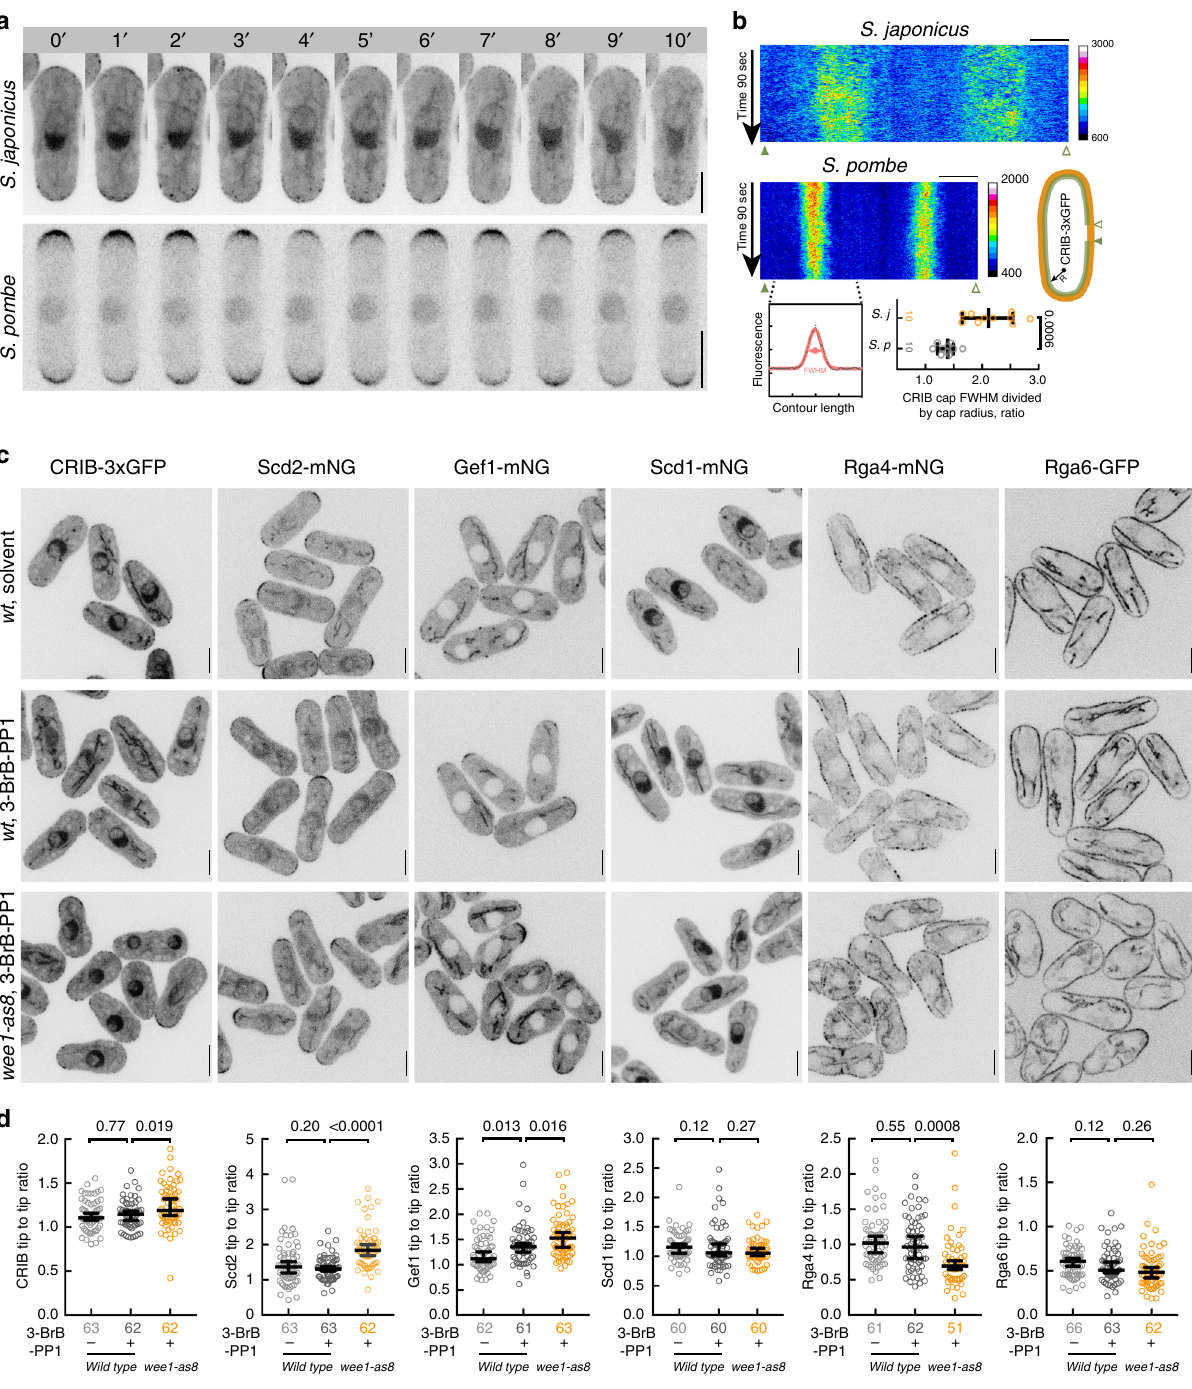
Fig. 2 Activation zones of the small GTPase Cdc42 rescale during morphological transition. a Time-lapse montages of interphase S. japonicus (top) and S. pombe (bottom) cells expressing a Cdc42 activity reporter CRIB-3xGFP. Shown are maximum intensity z -projections of spinning-disk confocal images. b Representative kymographs of CRIB-3xGFP at cell periphery in both species (top). 16-Color calibration bars indicate fl uorescence intensities in arbitrary units. A diagram showing FWHM fi t (full width of the domain at half maximum, bottom left), normalized to cell tip radii (right). c Single plane spinning-disk confocal micrographs of cells expressing indicated fl uorescent proteins in the wild type ( wt ) and wee1-as8 genetic backgrounds. Wild type cells were treated either with solvent control or 20 μ M 3-BrB-PP1 for 2 h. wee1-as8 cells were treated with 20 μ M 3-BrB-PP1 for 2 h. d Graphs show cellular tip-to-tip ratio in fl uorescent intensities of markers shown in ( c ). Note that CRIB-3xGFP, Scd2 and Gef1 become enriched at the hyperpolarized cell tip upon Wee1 inhibition, whereas Rga4 is largely excluded from these growing cell protrusions. a – c Scale bars represent 5 μ m. b , d Quanti fi cations presented as 1D- scatter plots; black bars represent sample median with error bars indicating 95% con fi dence intervals; n indicated in fi gures; p values derived